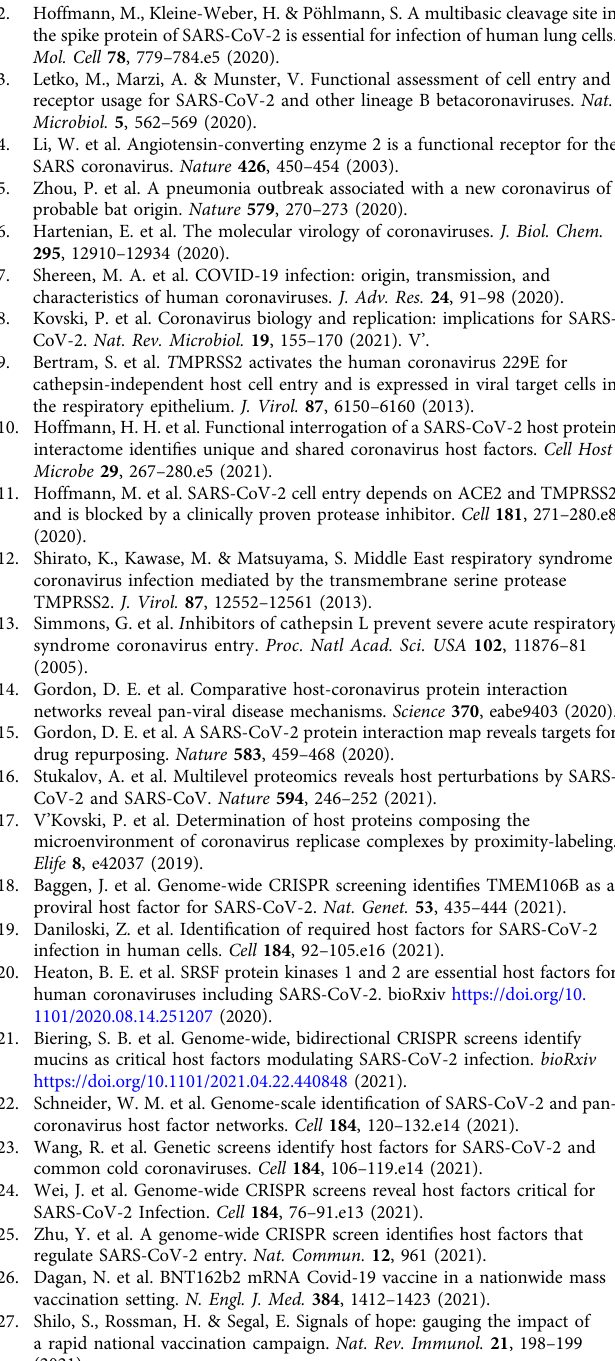
Table 2) were designed using the Primer Express Software (Applied Biosystems) and purchased from Integrated DNA Technologies, Inc. siRNA inhibition assay . Calu-3 Cells were transfected with siRNA validated for GATA6 or negative control (TriFECTa Kit DsiRNA Duplex, IDT) (listed in Sup- plementary Table 2) in the presence of Lipofectamine RNAiMAX reagent (Life Technologies), according to the manufacturer ’ s standard protocol. At the indicated time after transfection, cells were harvested. All experiments were performed in triplicate, and representative results are reported. RT-PCR . Total RNA was extracted using RNeasy Mini Kit (Qiagen 74104), reverse transcribed using qScript cDNA Synthesis kit (95047-025, Quanta bio) according